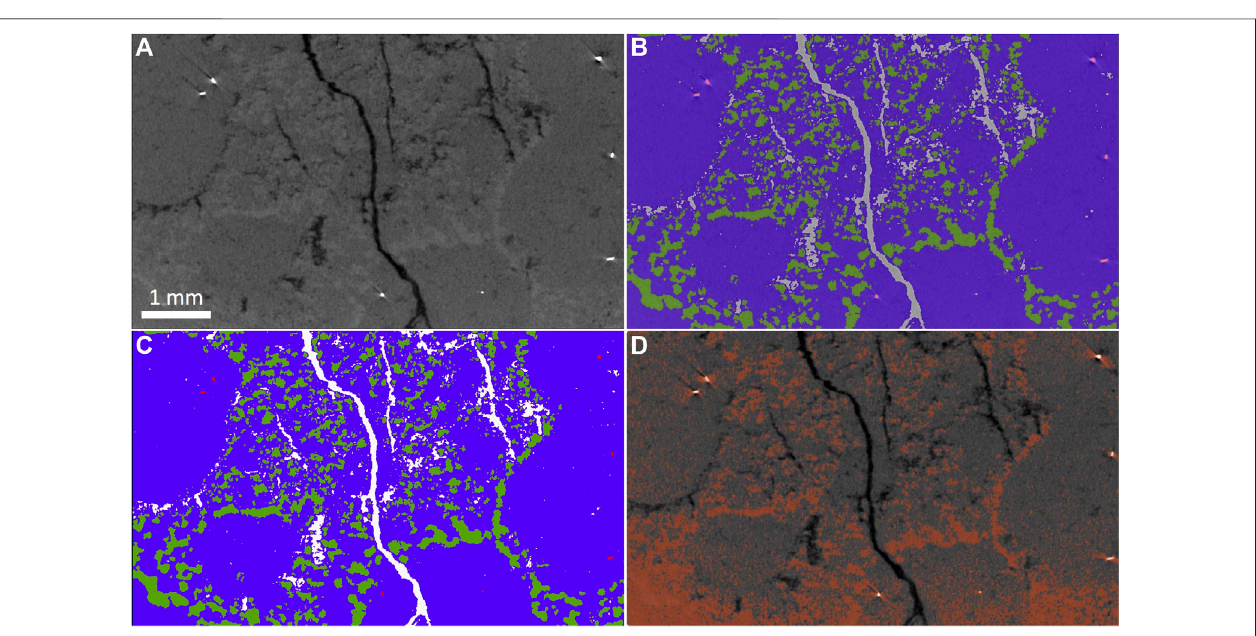
FIGURE 3 | (A) : Reconstructed CT image of scan RM1.29 VOI; (B) : Reconstructed CT image overlaid with the segmentation result of that slice (blue: ISS; green: MSS; red: PGM; white: background); (C) : Segmented data of the CT slice (blue: ISS; green: MSS; red: PGM; white: background); (D) : Segmentation result using interactive thresholding to segment ISS and MSS, with MSS in